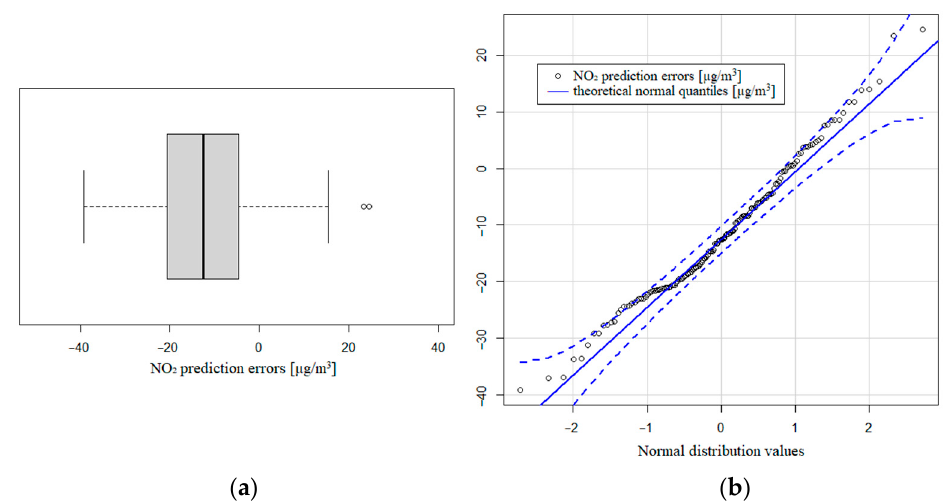
Figure 8. ( a ) Boxplot of NO ₂ prediction errors; ( b ) theoretical normal quantiles compared to prediction errors.